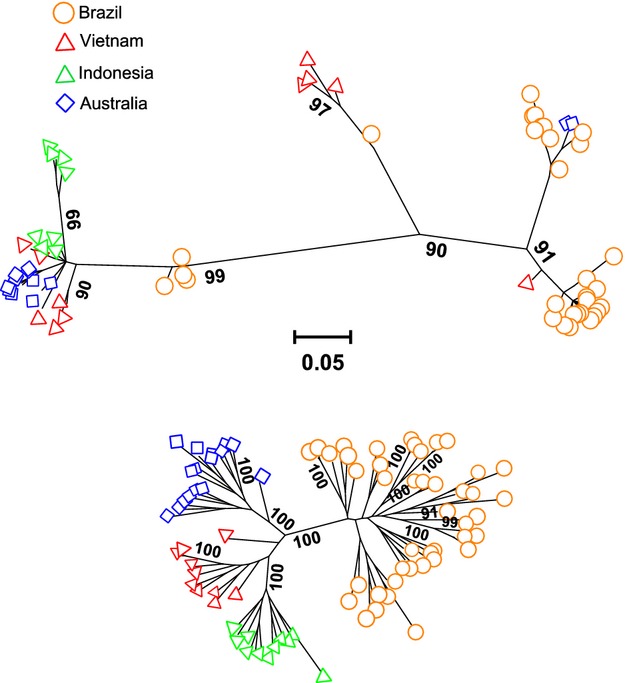
Maximum likelihood (ML) phylogeny. ML phylogenetic reconstructions from RAxML based on mitochondrial genomewide single nucleotide polymorphisms (SNPs) (upper) and nuclear genomewide SNPs (lower) for Aedes aegypti samples from Rio de Janeiro (Brazil), along with samples from Australia, Indonesia, and Vietnam. Only bootstrap support values ≥90% are shown. Scale represents mean number of nucleotide substitutions per site.